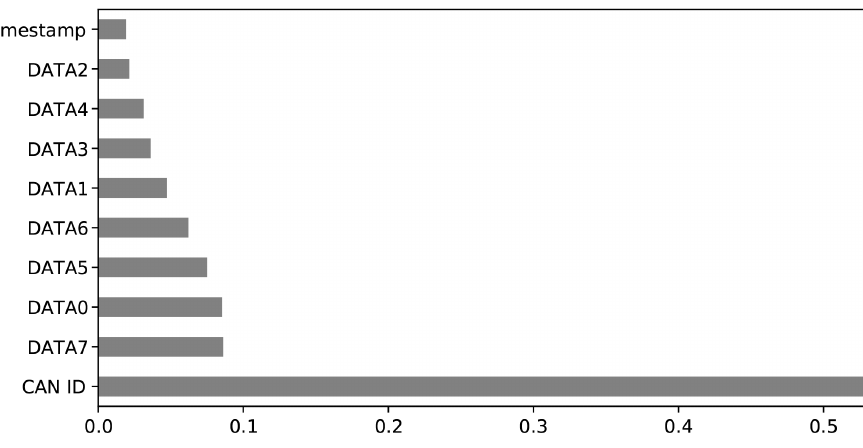
Figure 6. Car-hacking dataset ranked